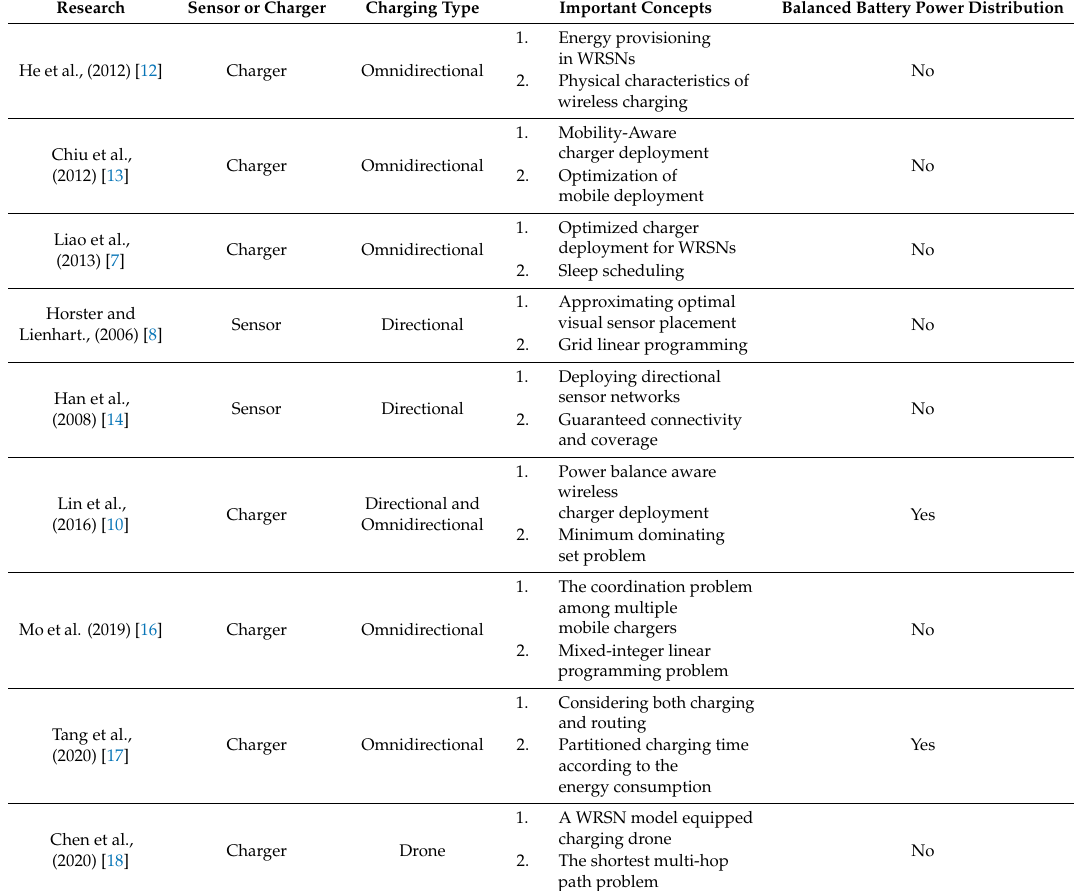
Table 1. Related deployment